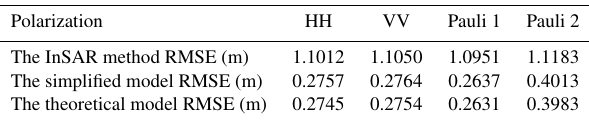
Table 1. The RMSE of model-retrieved height for the four polariza-